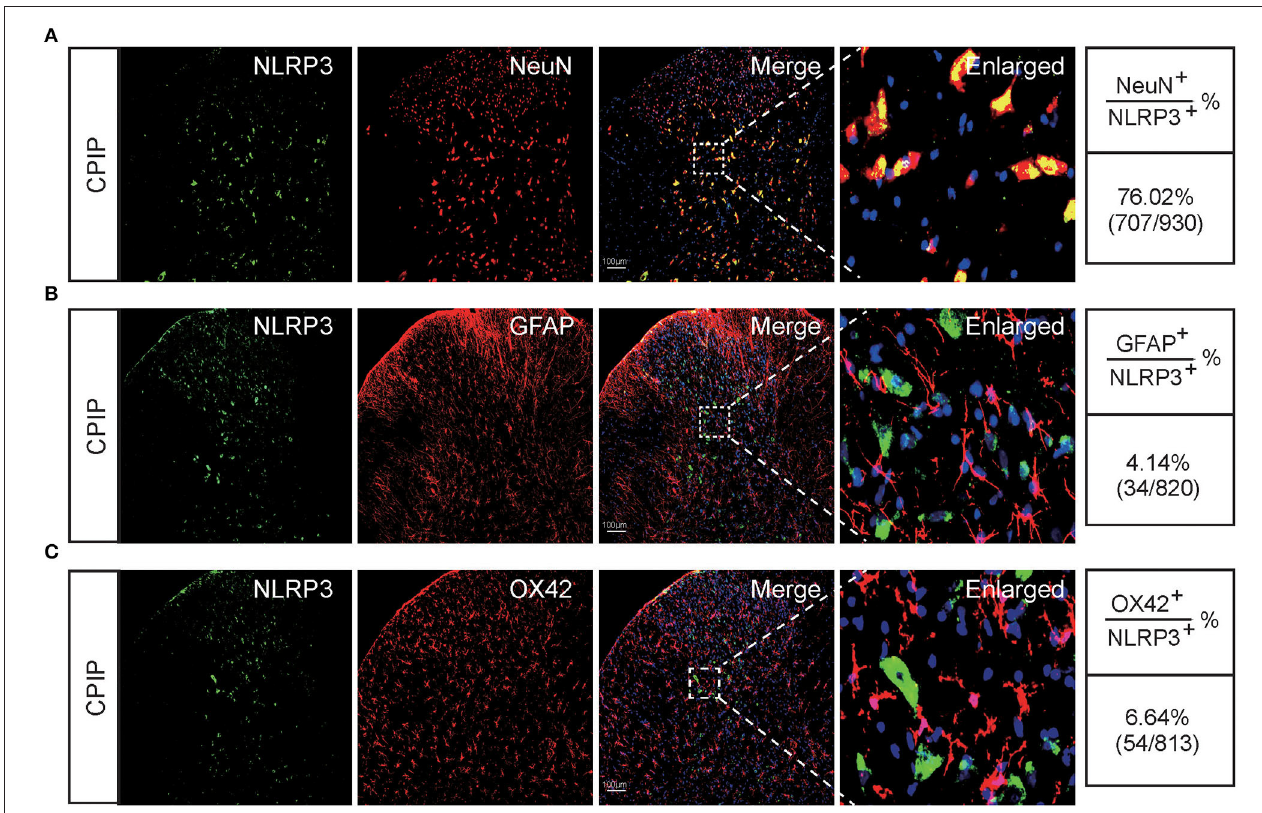
FIGURE 3 | The cellular distribution of NLRP3 in spinal cord dorsal horn of CPIP model rats. (A–C) Double immunostaining showing NLRP3 (in green) co-expression with the neuronal marker NeuN ( A , in red), astrocyte marker GFAP ( B , in red) and microglial cell marker OX42 ( C , in red) in ipsilateral spinal cord dorsal horn of CPIP rats. DAPI (in purple) was used as counterstain. Quantification is illustrated on the right of the panels. Scale bar indicates 100 µ m. Data were obtained from 9 rats/group.